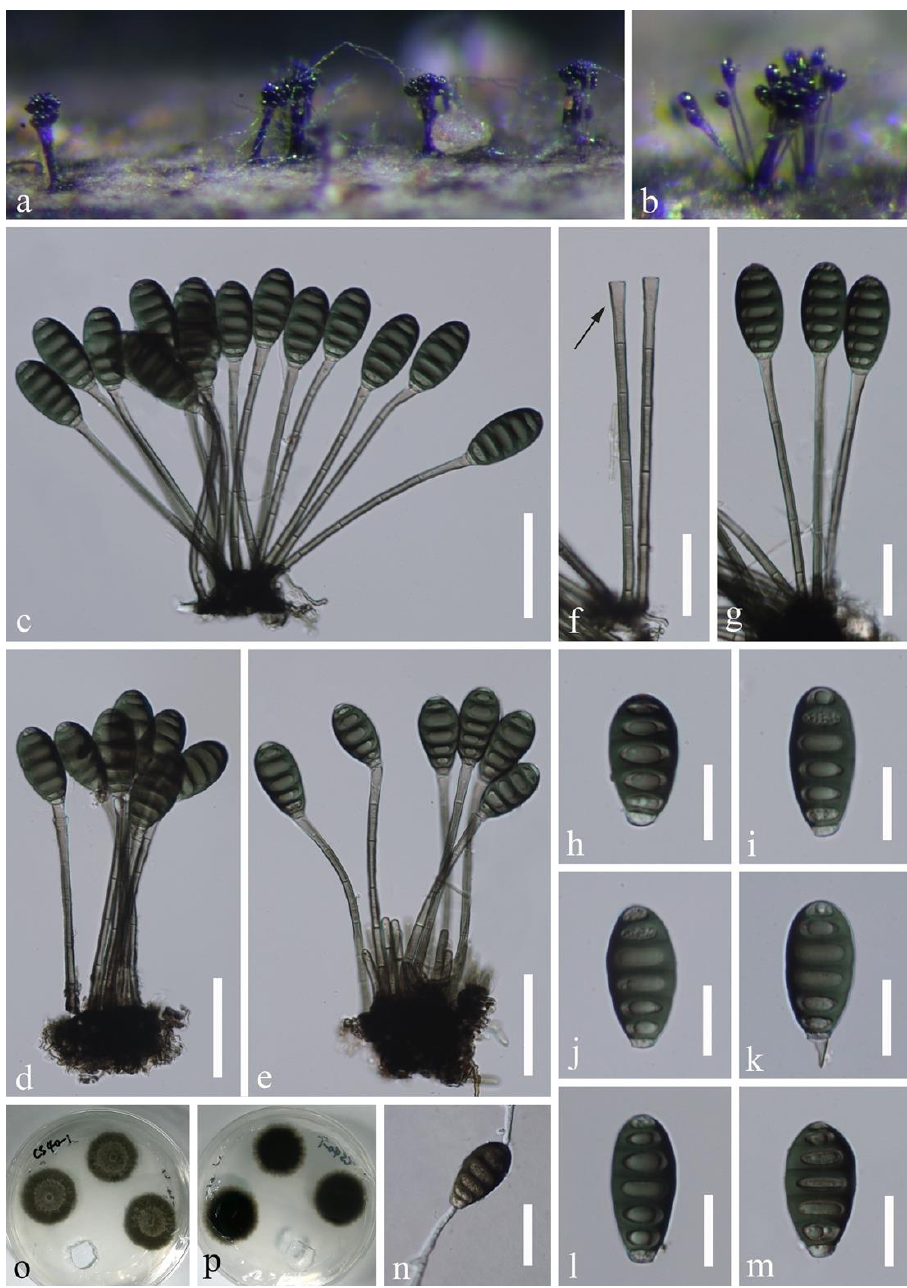
Figure 3. Distoseptispora atroviridis (HKAS 112616, holotype). ( a , b ) Colonies on woody substrates. ( c – e , g ) Fasciculate conidiophores with conidia. ( f ) Conidiophores and conidiogenous cells. ( h – m ) Conidia. ( n ) Germinated conidium. ( o , p ) Culture, ( o ) from above, ( p ) from below. Scale bars: ( c – e ) 50 µ m, ( f , g , n ) 30 µ m, ( h – m ) 20 µ